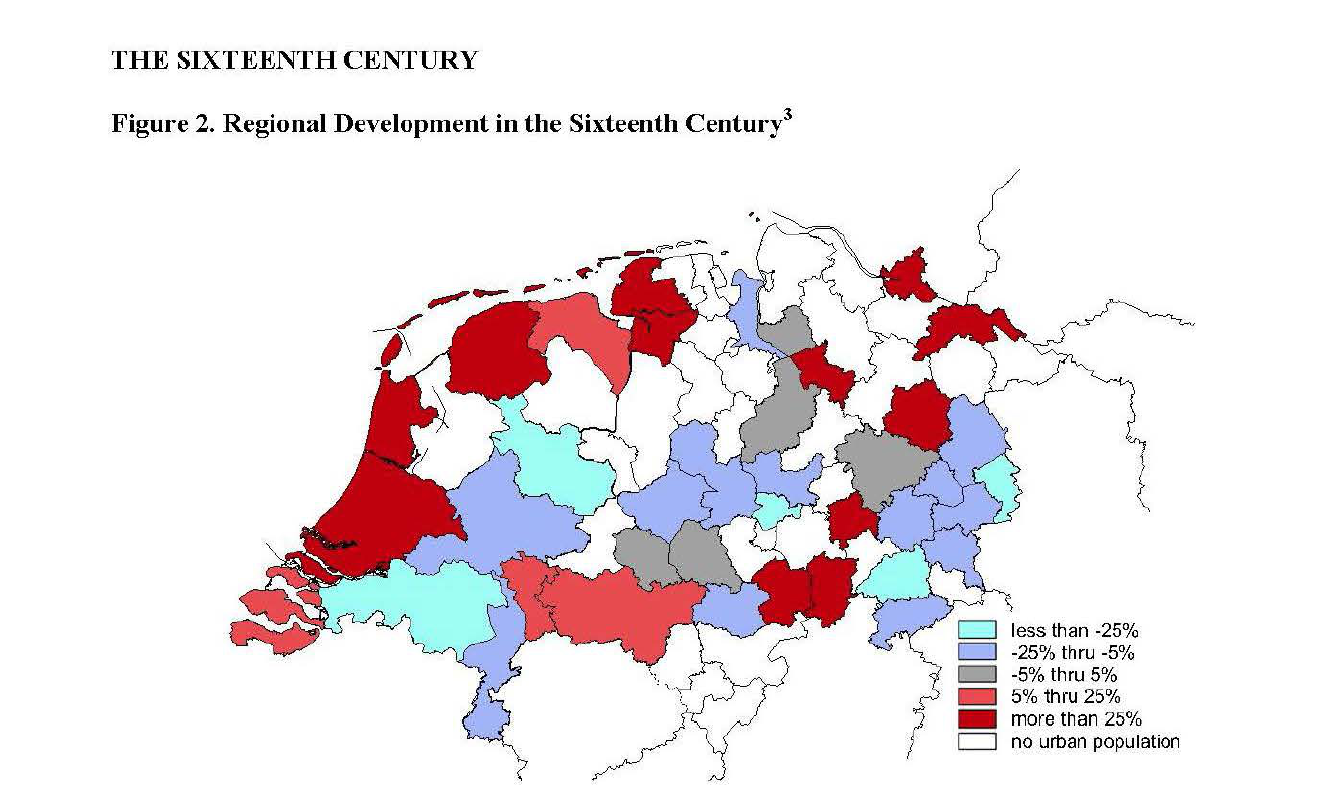
Figure 2. Regional Development in the Sixteenth Century